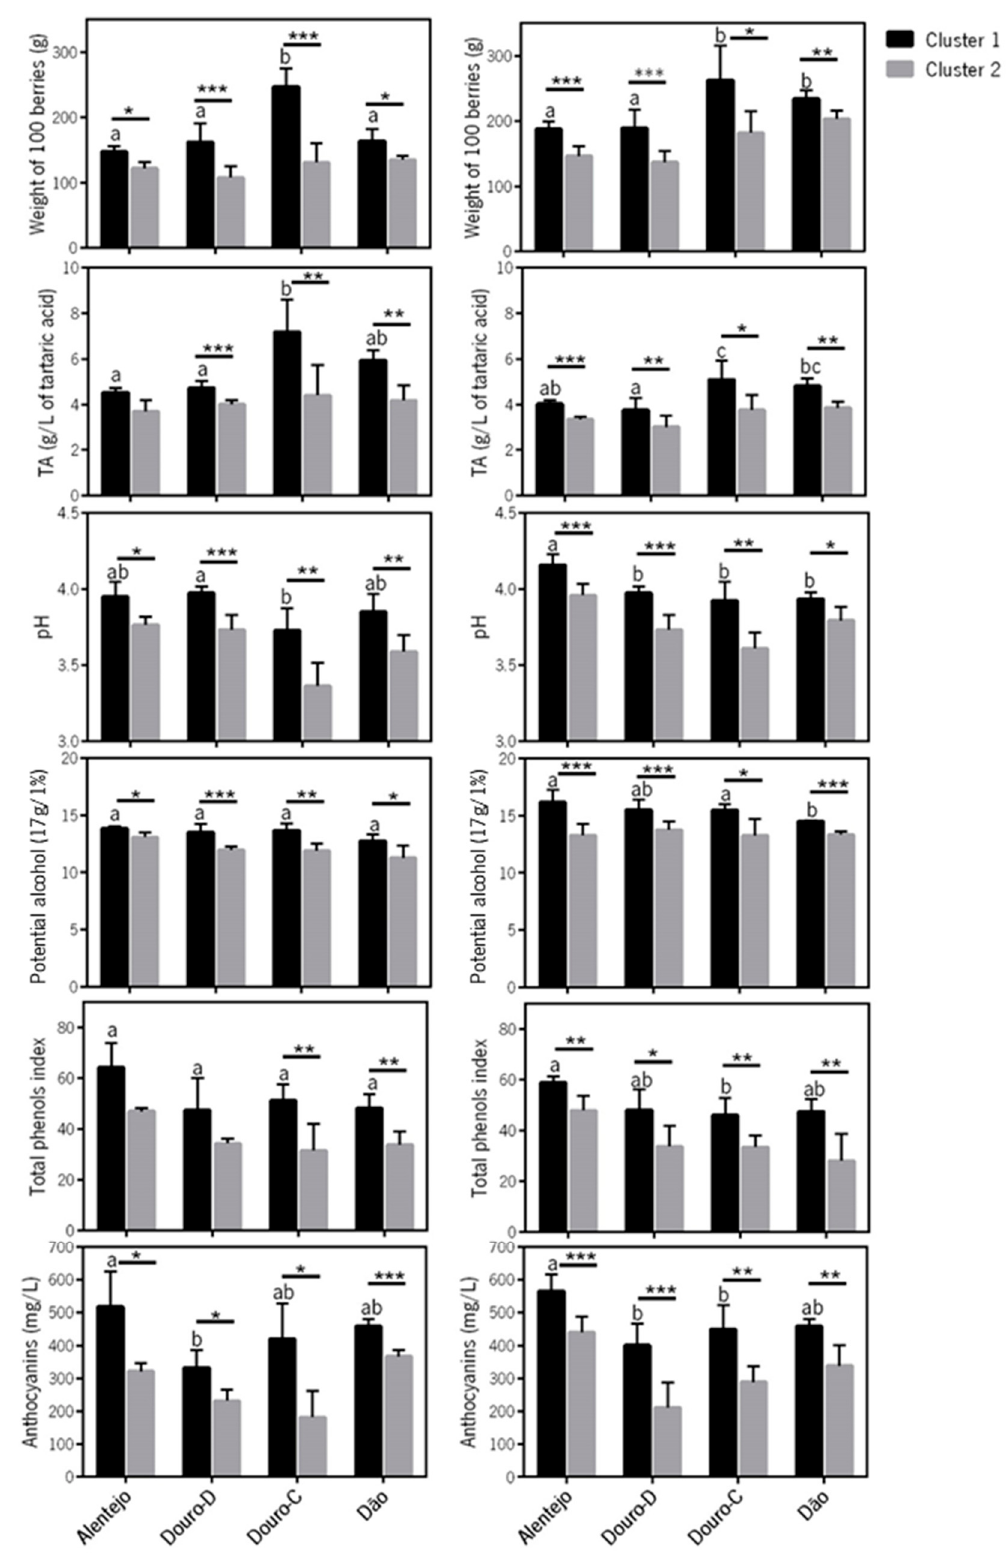
Figure 5. Grape berry quality parameters at maturity for TON (left panel) and ARA (right panel). The sites are listed from left to right according to average GST (April to October) in decreasing order. The bars represent the cluster-mean, the whiskers the standard deviation and statistically significant differences between clusters are indicated by asterisks (* p ≤ 0.05, ** p ≤ 0.01, *** p ≤ 0.001). Different letters indicate statistically significant differences between regions (for cluster 1).